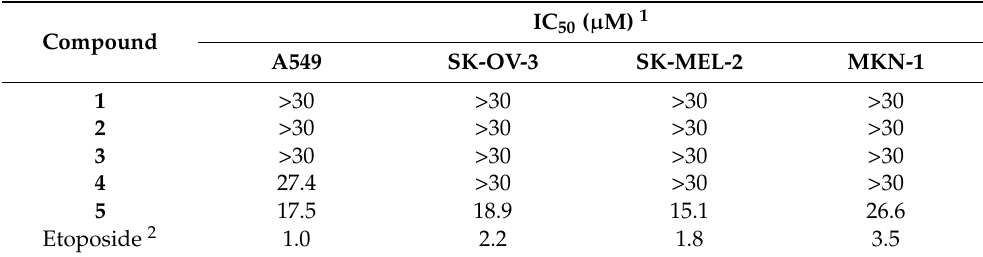
Table 4. Cytotoxicity of compounds 4 and 5 in four cultured human cancer cell lines measured with the SRB